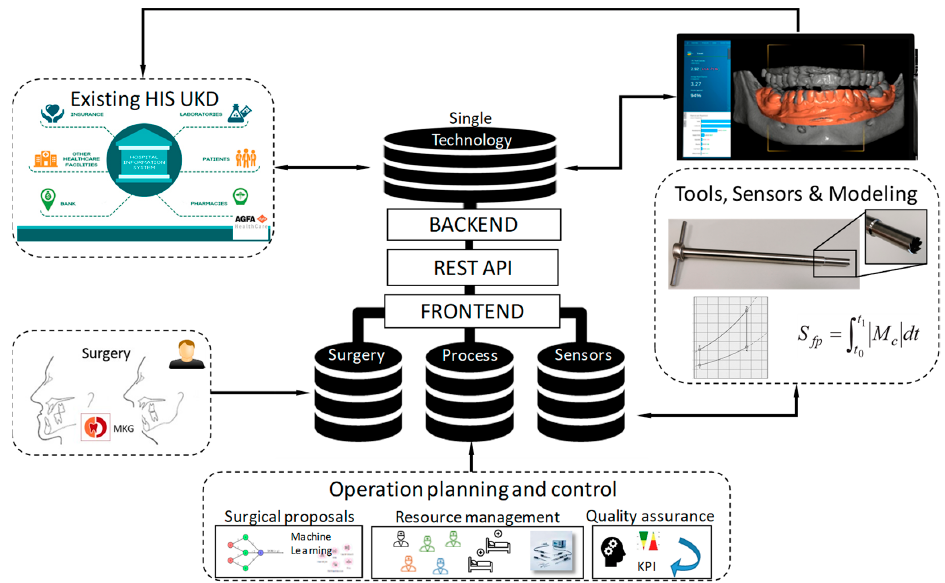
Figure 5. Architecture and data flow in Dental Tech Space (DTS).